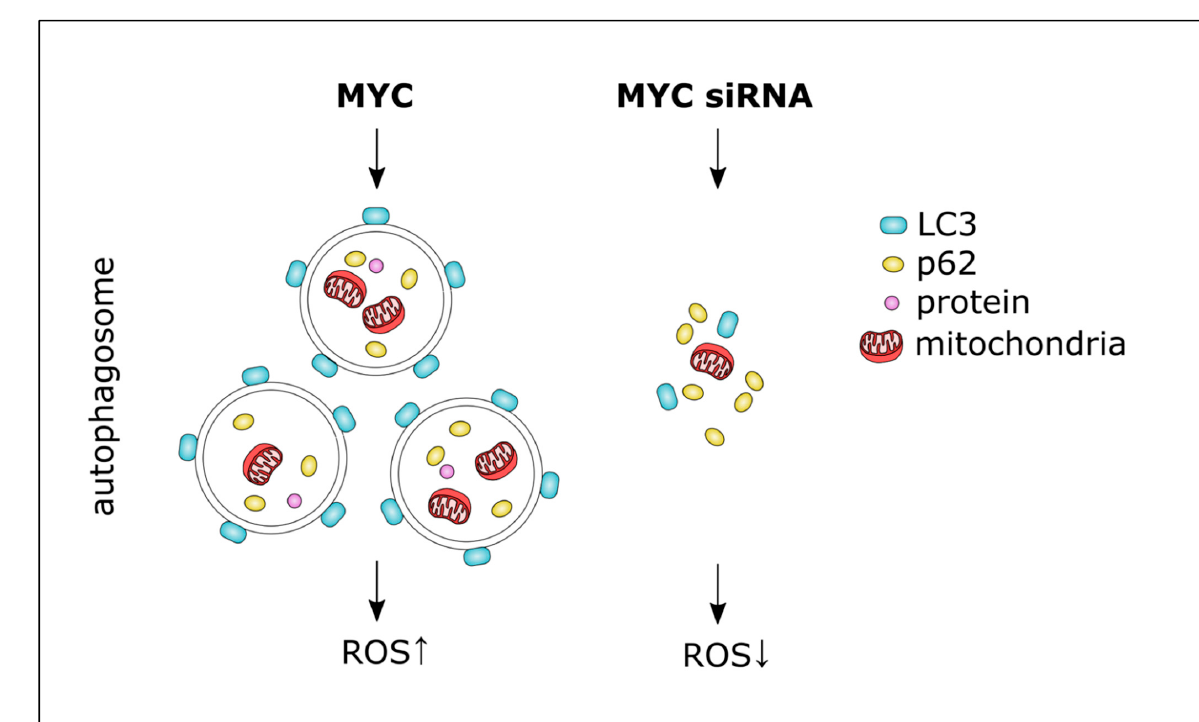
Figure 4. MYC and autophagy. MYC was involved in autophagosome formation whereby siRNA-mediated knockdown of MYC inhibited autophagy, resulting in the accumulation of the autophagy substrate p62. MYC is known to trigger ROS